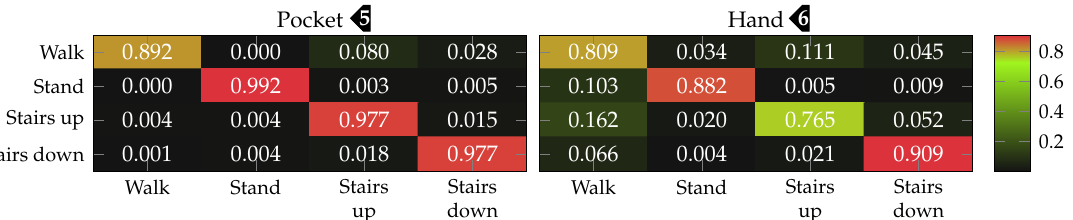
Figure 16. Final confusion matrices for the best-performing configuration (PCA, 5 dimensions, 2s windows, raw acceleration) of the analytical transformations approach for pocket-case and hand-case using an SVM classifier. Each row represents the actual class, each column the classification